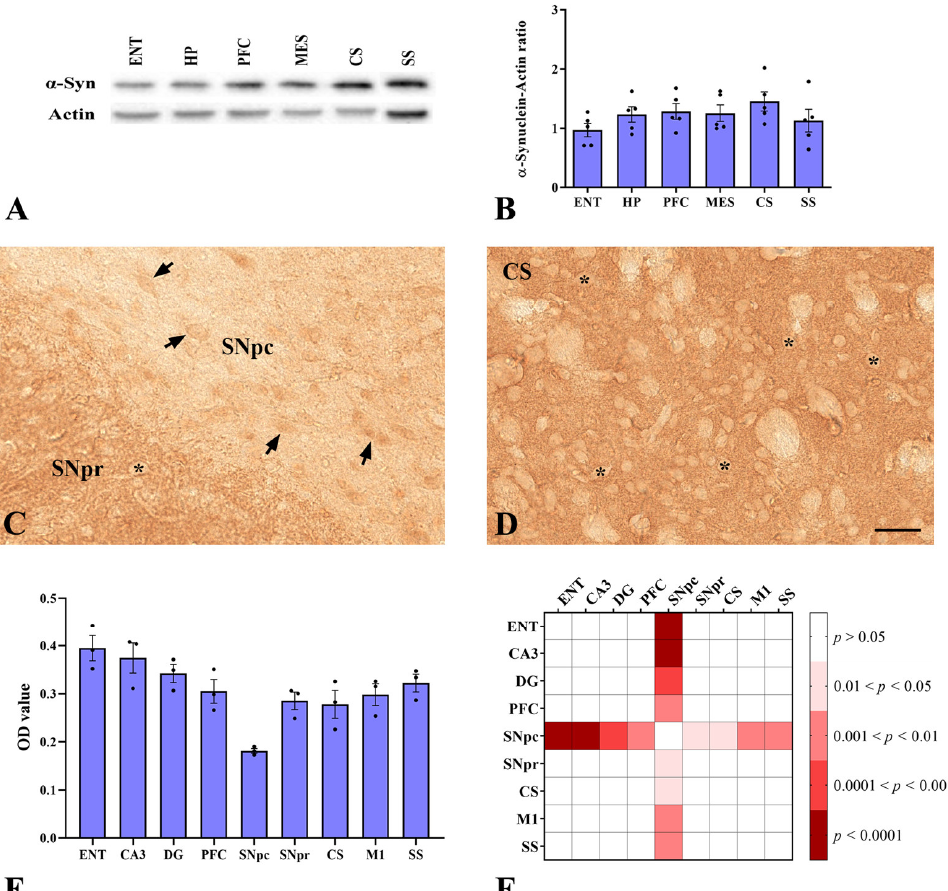
Figure 1. α -synuclein expression in WT murine brain. ( A , B ): Western blot analysis of α -synuclein levels in total lysates obtained from different cerebral regions. ( A ): Representative western blot showing α -synuclein levels in total lysates of entorhinal cortex (ENT), hippocampal formation (HP), prefrontal cortex (PFC), ventral mesencephalon (MES), corpus striatum (CS), and somatosensory cortex (SS). Actin is used as loading reference. ( B ): Quantification of α -synuclein protein levels normalized to actin. Data are mean ± SEM ( n = 5 mice); One-way ANOVA was used for statistical analysis followed by Bonferroni’s multiple comparisons test. ( C , D ): α -synuclein immunoperoxidase staining in coronal sections of WT mice brain. Light microscope images of α -synuclein immunolabeling in the substantia nigra pars compacta (SNpc) and reticulata (SNpr; ( C )) and corpus striatum (CS; ( D )). α -synuclein staining is punctiform and mainly neuropilar. The asterisks showed that the cell bodies are not labelled, except in the SNpc (arrows). Scale bar: 40 µ m. ( E ): Densitometric analysis of α -synuclein immunoperoxidase staining in different areas of WT mice brain. Data are shown as mean optical density ± SEM ( n = 3 mice). One-way ANOVA was used for statistical analysis followed by Bonferroni’s multiple comparison test as described in the Materials and Methods section. p values are graphically represented in the heat-map in ( F ) (P60, n = 3). CA3: Cornu Ammonis region 3; DG: dentate gyrus; M1: primary motor